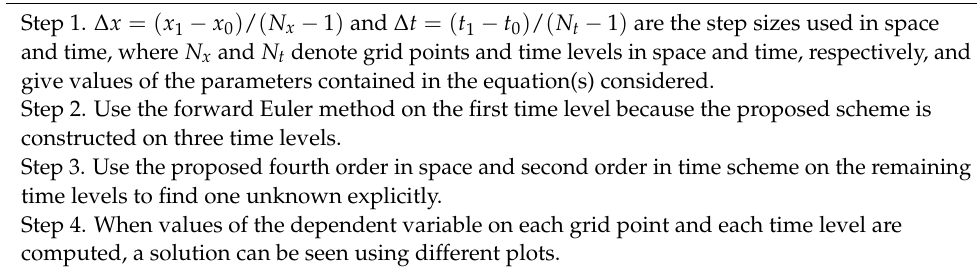
Algorithm 1. In the beginning, the smallest and largest values of spatial and temporal variables have been